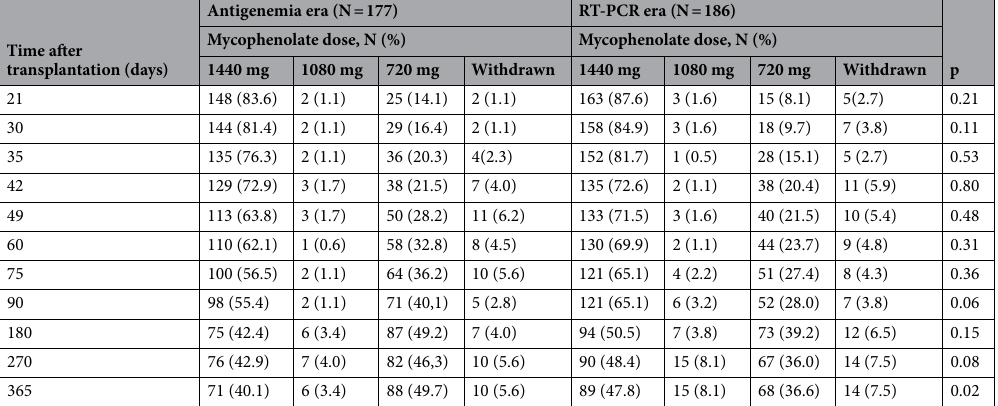
Table 2. Doses of acid mycophenolate over the follow-up. Values expressed in absolute values (%). The missing values are those who used Mycophenolate 360 mg.